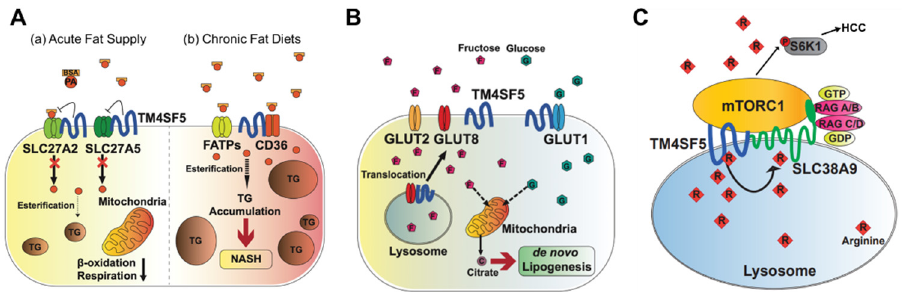
Figure 2. Metabolic regulation by TM4SF5. TM4SF5 can alter the metabolism of lipids, glucose/fructose, and arginine, resulting in the development of various features of chronic liver diseases. ( A ) Depending on the acute or chronic fatty acid or the fat supply, TM4SF5 in hepatocytes may negatively or positively support the transport activities of the fatty acid transporters via associations with the transporters, respectively. In case of acute supply, hepatocyyte TM4SF5 expression appears to reduce the fatty acid trasporting activity of SLC27A2 and SLC27A5, leading to less fat accumulation in the cells, whereas chronic intake of excess fatty acids leads to TM4SF5-mediated nonalcholoic steatohepatitis due to increased fatty acid uptake and accumulation. ( B ) When excessive fructose is available, TM4SF5 in hepatocytes causes GLUT8 from endosomal membranes to move toward plasma membranes following its release from their interaction, leading to increased GLUT8-mediated fructose uptake and, eventually, de novo lipogenesis (DNL). ( C ) Depending on the availability of extracellular (and thereby lysosomal) L-arginine, TM4SF5 binds to and causes mTOR to be translocated to lysosomal membranes, where TM4SF5 localizes and also binds to the L-arginine transporter (SLC38A9, solute carrier family 38 member 9) at the lysosome. The binding affinity of L-arginine to TM4SF5 is greater than that to SLC38A9, leading to the sensing of physiological L-arginine levels in the lysosomal lumen, enough for the export of L-arginine via SLC38A9 to the cytosol. This causes mTOR and S6K1 activation and, eventually, HCC development. FATPs, fatty acid transport proteins; CD36, fatty acid translocase; SREBP1, sterol regulatory element-binding protein 1; GLUT, glucose transporter; mTORC1, mechanistic target of rapamycin complex 1.